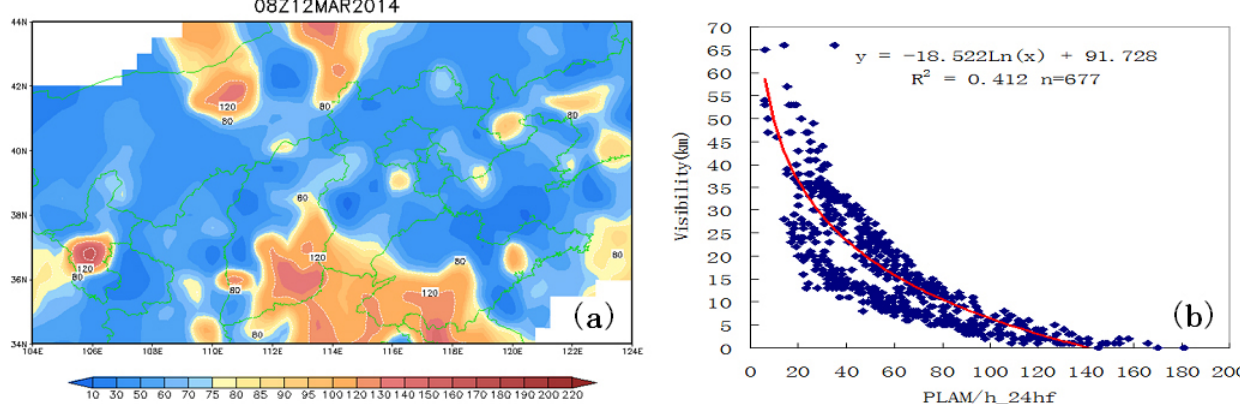
Figure 8. Distribution of PLAM/h in North China (a) and correlation analysis of PLAM/h index 24h forecasts and observed visibility (b) in North China for 08:00 (UTC + 8) on 12 March 2014 .